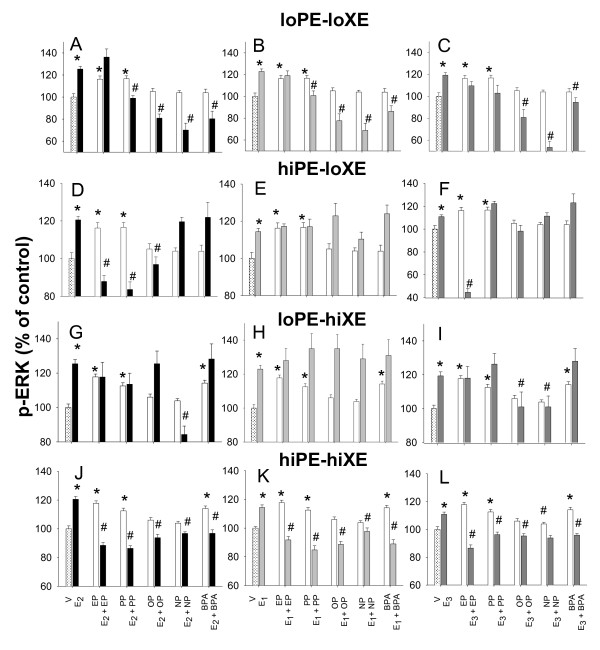
Changes in pERK levels elicited by physiologic estrogens (PE) and xenoestrogens (XE), alone and in combination. The levels of activated ERKs (pERK) were measured in cells treated with (A-C) 10 pM of the physiologic estrogens (E2, E1, or E3 ) alone or in combinations with 10 pM of different alkylphenols (EP, PP, OP, NP, or BPA), row labeled lo PE - lo XE; (D-F) 1 nM of the physiologic estrogens alone or in combinations with 10 pM of different alkylphenols, row labeled hi PE - lo XE; (G-I) 10 pM of the physiologic estrogens alone or in combinations with 1 nM of different alkylphenols, row labeled lo PE - hi XE; (J-L) 1 nM of the physiologic estrogens alone or in combinations with 1 nM of different alkylphenols, row labeled hi PE - hi XE. * = p < 0.05 compared to vehicle (V) control cells. # = p < 0.05 compared to E2, E1, or E3 alone.